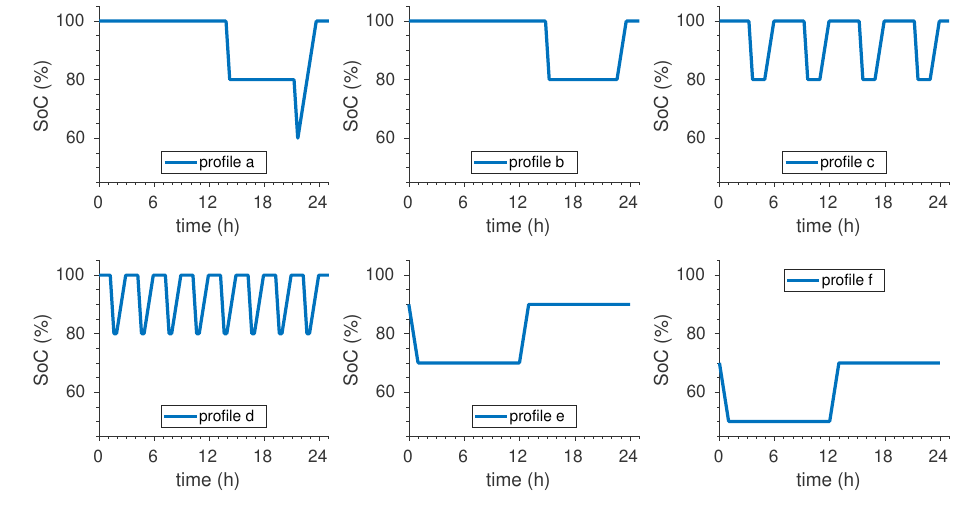
Figure 1. Cycling